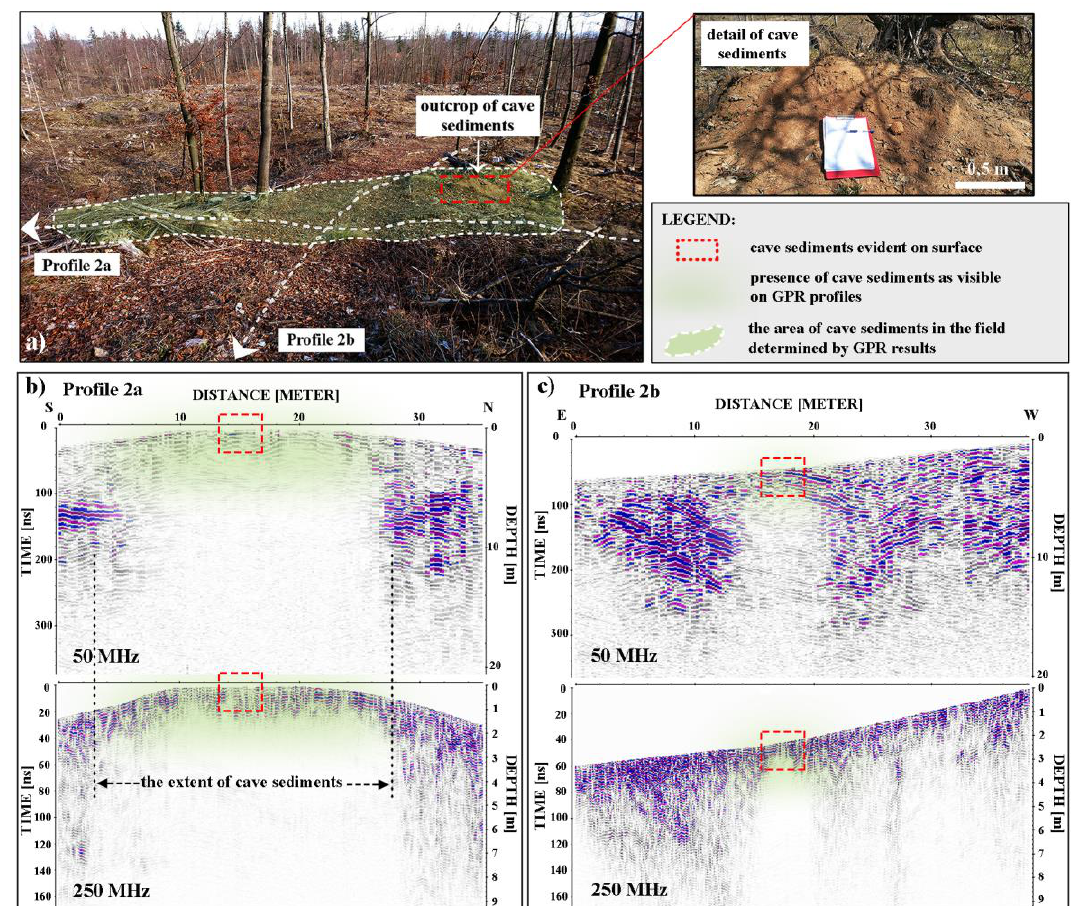
Figure 8. ( a ) Direction of perpendicular Profiles 2a and 2b recorded with a 50 and 250 MHz antenna (vertical exaggeration of the 250 MHz GPR images is 1:2) in the area of the cave sediments outcrop to determine their spatial extent; ( b ) Extent of cave sediments was determined in Profile 2a; ( c ) Boundaries of cave sediments detected by GPR are limited to the area of the outcrop visible on the surface.